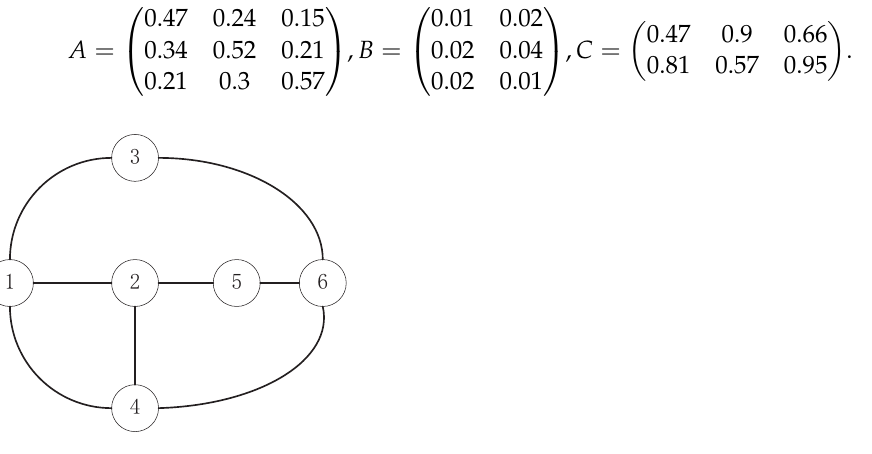
Figure 9. Communication